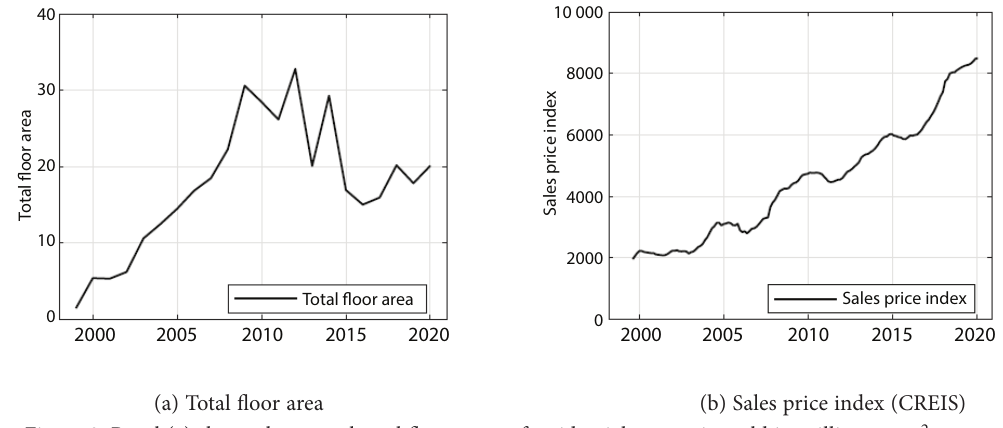
Figure 2. Panel (a) shows the annual total floor areas of residential properties sold in million meter 2 over 1998–2020 in Shanghai. Panel (b) shows the monthly sales price index in the second-hand housing market